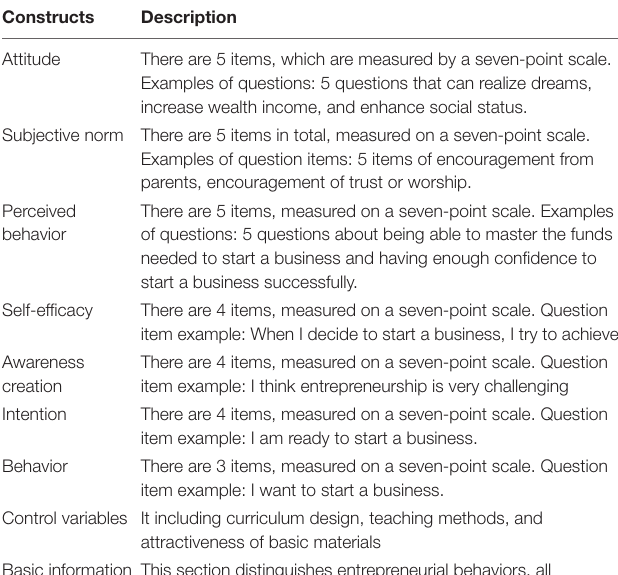
TABLE 1 | Construct description and example